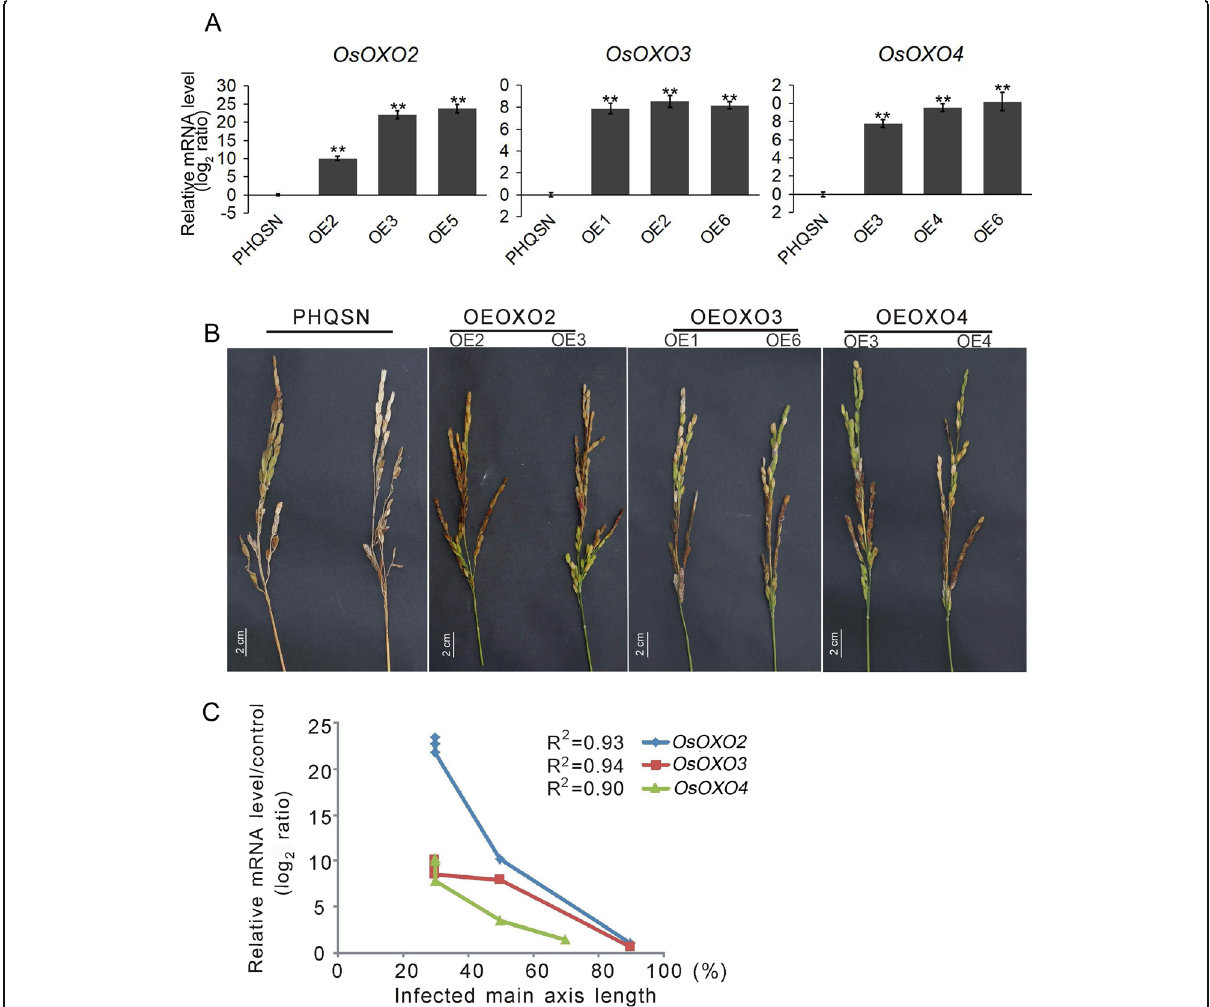
Fig. 2 The disease phenotypes of the OXO gene overexpressing plants before and during panicle blast infection. OEOXO2 indicates the plants overexpressing OsOXO2 , OEOXO3 indicates the plants overexpressing OsOXO3 and OEOXO4 indicates the plants overexpressing OsOXO4 . a Transcription analysis of OsOXO2 , OsOXO3 and OsOXO4 in their corresponding overexpressing plants. Error bars indicate the SD from three biological replicates. ** indicates a statistically significant difference compared with PHQSN ( t test, P < 0.01). b Disease phenotypes of OEOXO2, OEOXO3, OEOXO4, and the empty vector control (PHQSN) plants at the heading stage after inoculation with M. oryzae using the cotton- wrapping method. c Correlation analysis between enhanced resistance and the expression levels of OsOXO2 , OsOXO3 and OsOXO4 in the overexpressing plants after panicle blast inoculation. The correlation coefficient is calculated by linear